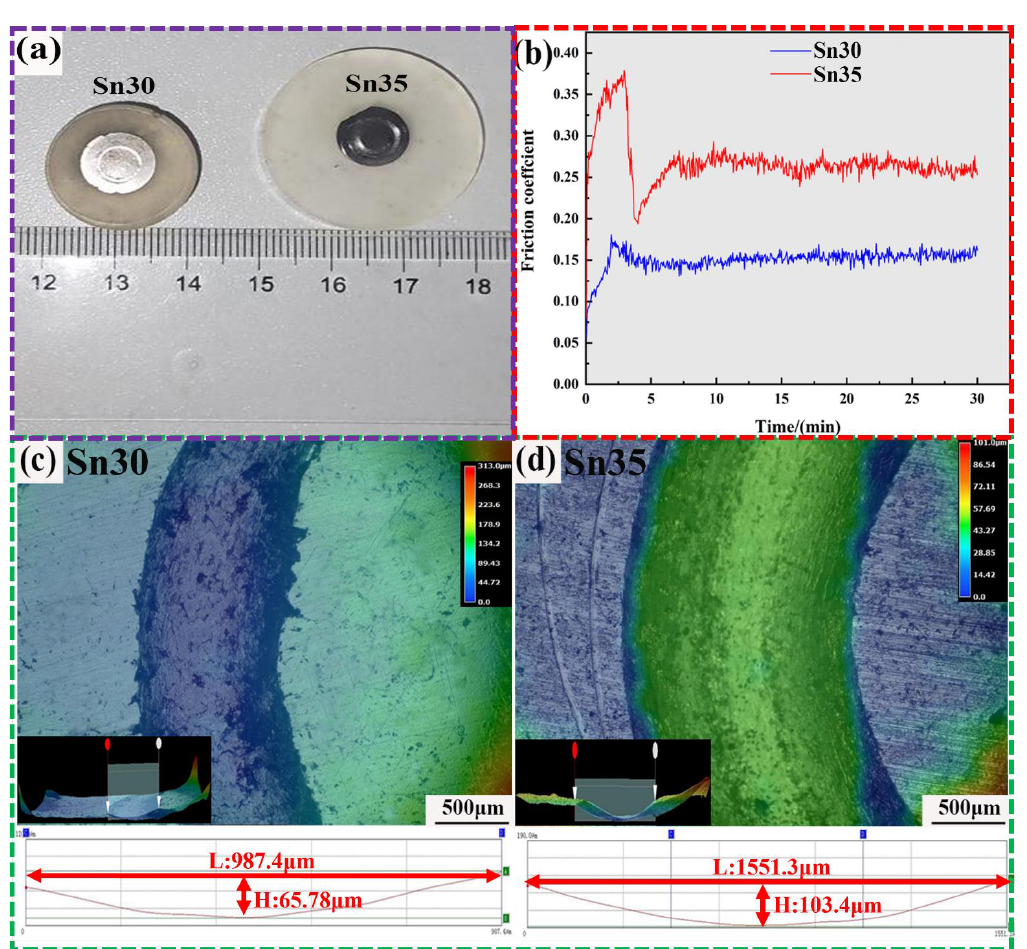
Figure 6. Friction and wear test results of Sn30 BHEA and Sn35 BHEA ( a ) samples, ( b ) friction coefficient curves, and profiles of the worn surfaces for sintered composites and corresponding 2D cross-section profiles of wear tracks: ( c ) Sn30 BHEA, ( d ) Sn35 BHEA.